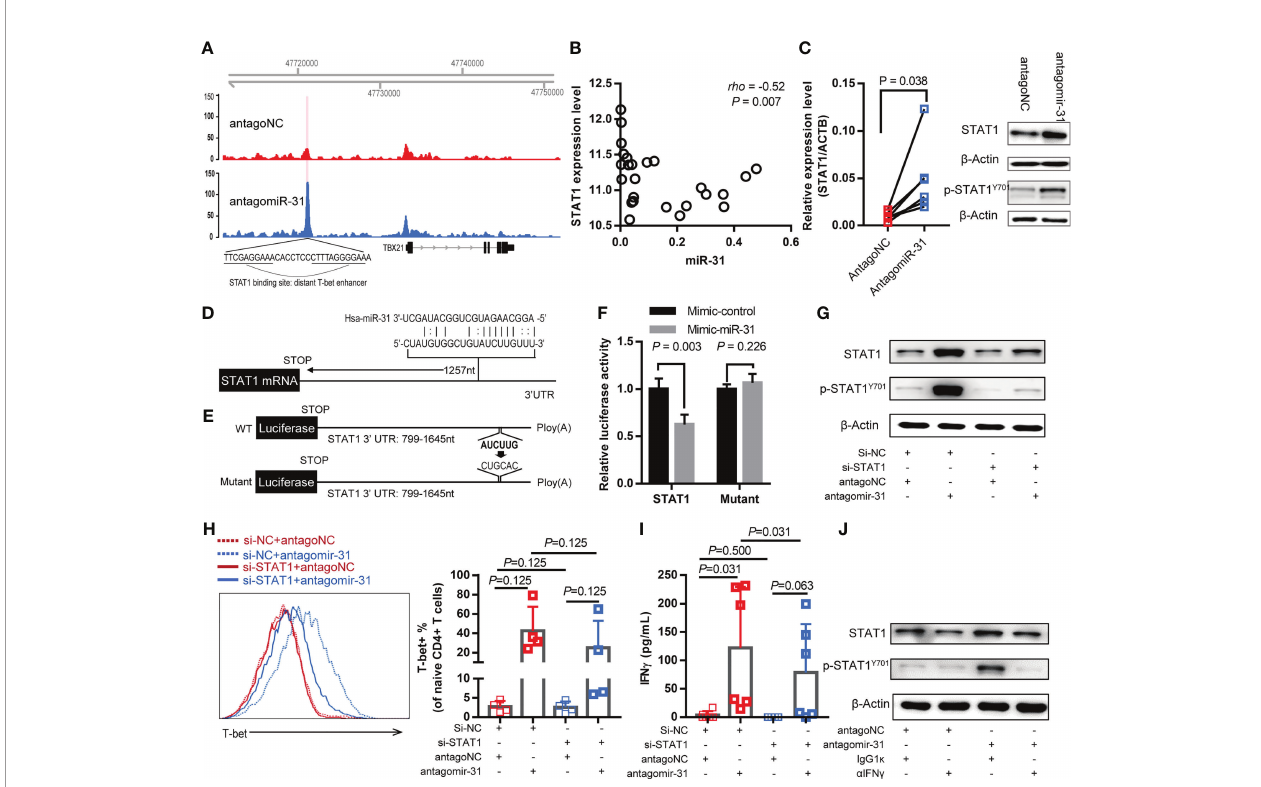
FIGURE 4 | miR-31 negatively regulates the IFN- g -STAT1-T-bet axis by directly targeting STAT1. (A) Genome browser view of accessible chromatin regions in the TBX21 locus, which encodes T-bet, in antagomiR-31-treated cells versus antagoNC-treated naïve CD4+ T cells. The differential peak was located at a distant enhancer containing a STAT1 binding site. Results are representative of ATAC-seq data obtained from two different donors. (B) Correlation between miR-31 level and STAT1 mRNA level in blood samples of HIV infected individuals (n = 25), measured by microarray and quantitative RT-PCR respectively. (C) Comparison of STAT1 mRNA and protein levels between antagomiR-31- and antagoNC-transfected naïve CD4+ T cells. mRNA levels of STAT1 were measured by quantitative RT- PCR and normalized to the level of ACTB (left panel, fold change = 5.10, n=6). Total STAT1, phosphor-STAT1 and internal control b ‐ actin were detected by western blotting, the representative immunoblot from 4 healthy donors was shown in the right panel. (D) Schematic illustration of putative miR-31 target site in the STAT1 3 ’ UTR. (E) Luciferase reporter constructs to verify the STAT1 targeting by miR-31. The nucleotide alterations intended to abolish the putative miR-31 target site was indicated. (F) Activities of luciferase reporter construct in 293T cells transfected with control mimic or miR-31 mimic. Data are presented as mean ± SD (n = 4). (G – I) Naïve CD4+ T cells were co-transfected with indicated 5 ’ -cholesterol modi fi ed siRNA and antagomir-31 or antagoNC. After 48 hrs, cells were harvested and subjected to western blotting for detection of total STAT1 and phospho-STAT1 (n=3) (G) and fl ow cytometry for assessment of T-bet-expressing cells (H) . The supernatants were also collected for IFN- g measurement using CBA (I) . The T-bet and IFN- g measurements were expressed as mean ± SD (n=6). (J) IFN- g dependency of antagomir-31-mediated STAT1 activation. Antagomir-31 or antagoNC-transfected naïve CD4+ T cells were exposed to IFN- g neutralizing antibody or isotype control antibody for 48 hrs, whole cell lysates were prepared for detection of total STAT1, phospho-STAT1, and b ‐ actin using western blotting